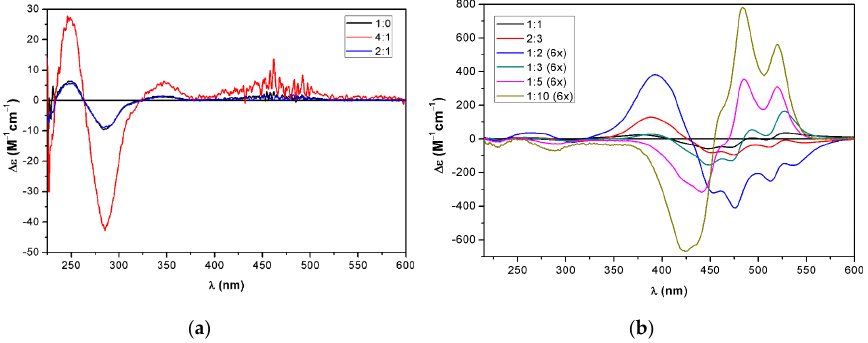
Figure 7. ECD spectra of monotriazole chrysin–zeaxanthin conjugate 23 in ( a ) THF / water 1:0–2:1. ( b ) THF / water 1:1–1:10.